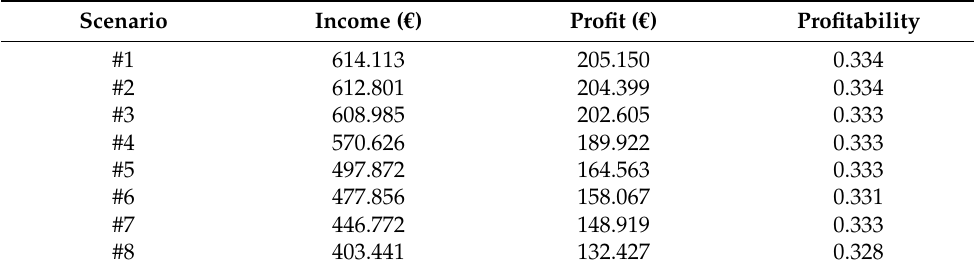
Table 6. Income, profit, and profitability for the various scenarios for 25 April 2019.